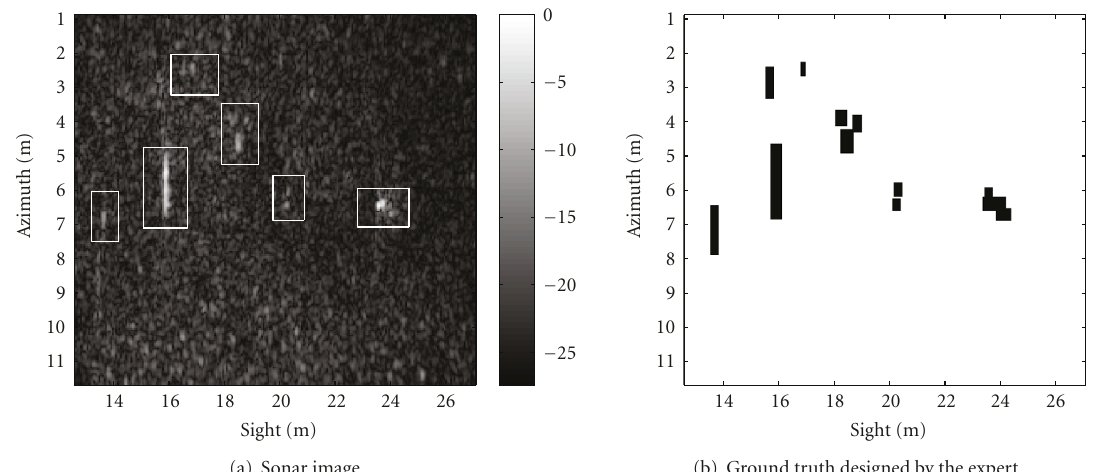
Figure 12: Example of image used for the environment truth.